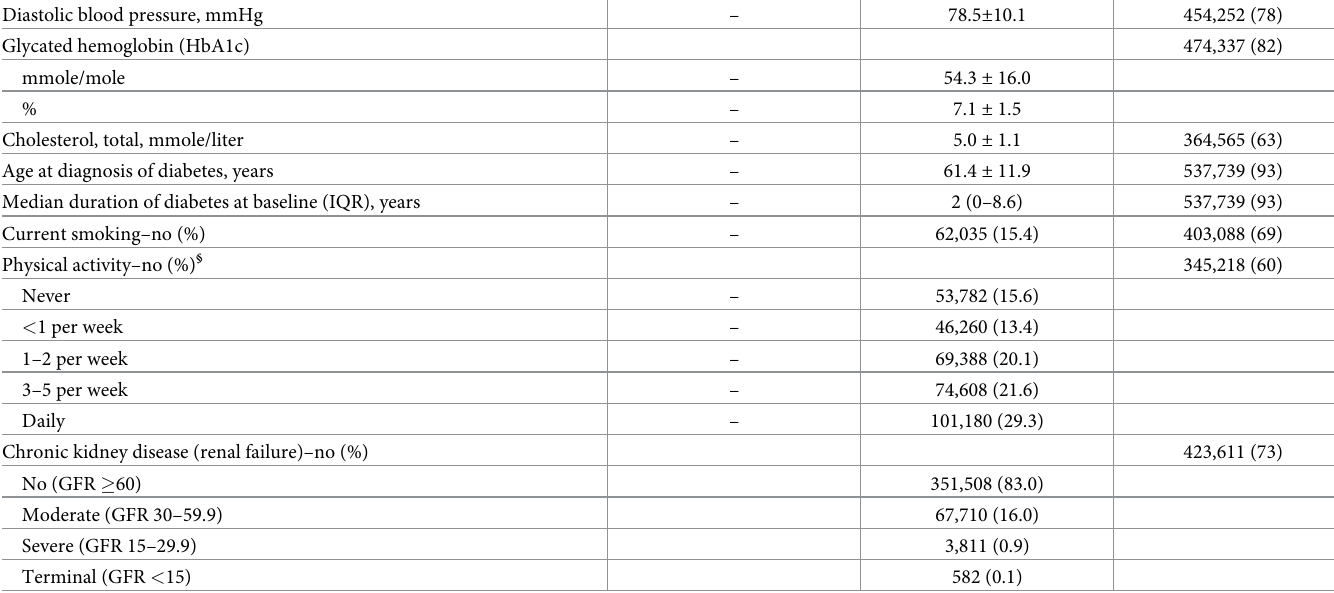
the table uses information from national registers covering all swedes, thus the information is available for both T2DM patients and controls. Part B of the table includes information from the Swedish National Diabetes Register and is only available for the T2DM case patients. Values are presented as mean ± SD, if not otherwise indicated. The historic window was since 1998 for fracture and fall, 5 years for other diagnoses and 1 year for medications. For detailed definitions of covariables, see S2 Table. � SMD, see S1 Appendix for formulas. All p -values (except for age and sex) were < 0.001. † Conditions associated with osteoporosis = hyperthyroidism, hypogonadism, malnutrition, osteogenesis imperfecta, chronic liver disease, hyperparathyroidism. ‡ N (%) = number of T2DM patients with available values and percentage of all T2DM patients (580,127). § Physical activity = 30 minutes’ walk or